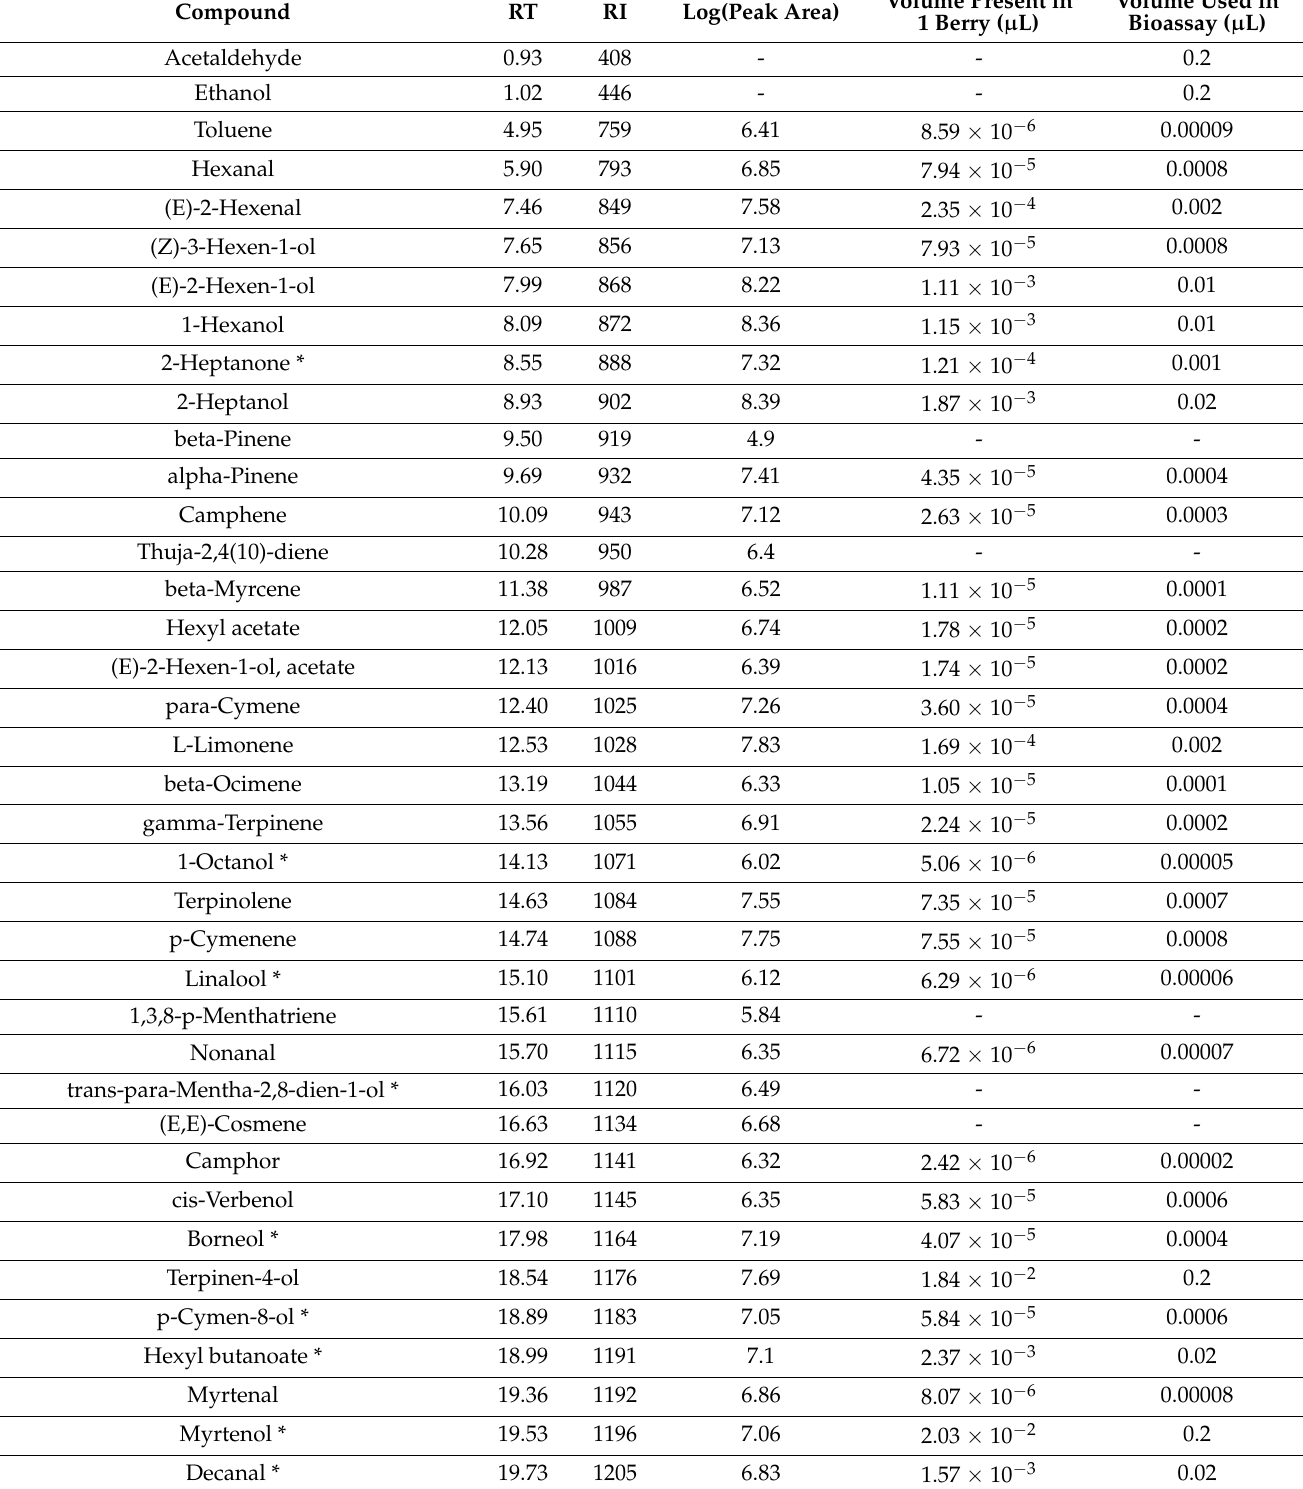
Table 1. List of all the volatile compounds identified and quantified via multiple headspace SPME GC-MS in Rubus fruticosus . The retention time (RT) and calculated retention index (RI) of each compound is shown. Summed peak area over fifteen repeated headspace extractions were calculated from the geometric mean sample average ( n = 4 samples). Compounds that show no calculated volume were not commercially available or were too volatile to be quantified accurately (acetaldehyde and ethanol). Asterisks indicate compounds with no clear reduction in peak area over fifteen